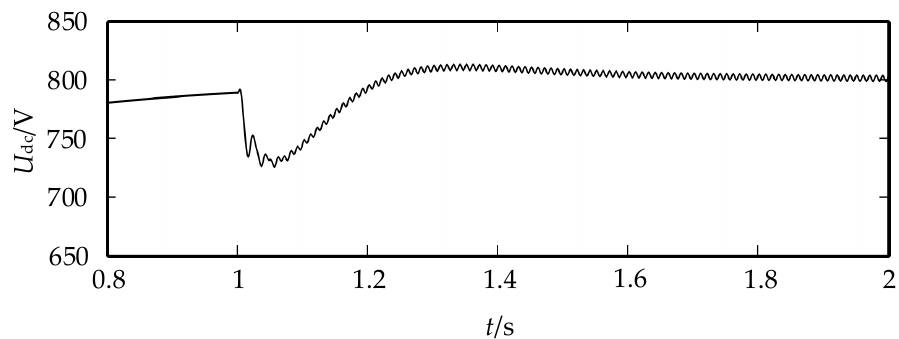
Figure 15. DC bus voltage with no current negative sequence.